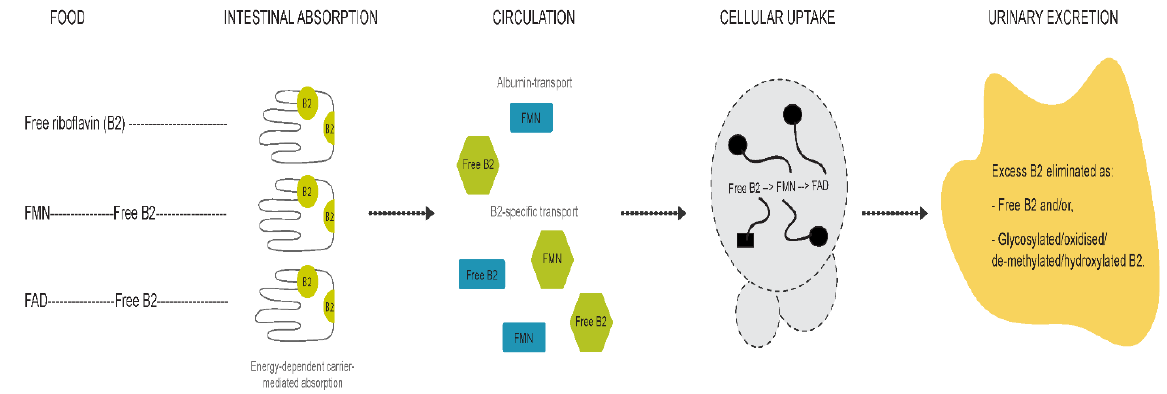
Figure 5. Graphical representation of vitamin B2 metabolism. Plasma concentrations of riboflavin, pantothenic acid, and 4-pyridoxic acid (4-PA) were positively associated with adult age (28–71 years). This is consistent with reports of age-specific changes in vitamin B6 status (i.e., decreases in pyridoxal 5’-phosphate (PLP) and/or plasma/urinary increases in its catabolite 4-PA) [20,34,35]. Age-dependent changes in B6 status have been proposed to be due to decreased intake, higher catabolic rates, increased enzymatic activity of alkaline phosphatase (responsible for PLP hydrolysis into pyridoxal (PL) and 4-PA), as well as variations in kidney function that impact B vitamer excretion [20,36,37]. The synthesis of PLP in tissues occurs via pyridoxine oxidation by FMN (riboflavin coenzyme) dependent enzymes (i.e., pyridoxine phosphate oxidase (PPO)) [37,38]. Since excess PLP is catabolized into PL then 4-PA, positive associations of 4-PA with age may reflect increased PLP turnover and catabolism with higher circulating riboflavin concentrations. Plasma pantothenic acid concentrations were also positively as- sociated with age. Notably, plasma concentrations of pantothenic acid are more readily affected by recent dietary intakes compared to its bound forms found within erythrocytes (i.e., coenzyme A) [39]. Studies in rural Japan have reported a decline in erythrocyte pan- tothenic acid with age, and proposed a potential decreased capacity of synthesising bound pantothenic acid in older adults [39–41]. While results from exclusively rural areas may not be relevant to populations in Australia, it is plausible to suggest that recent dietary intake affects plasma pantothenic acid, or that higher plasma pantothenic acid may reflect a lower capacity of synthesising its bound form in the tissues of older individuals. These age-dependent differences highlight the need to account for age when profiling B vitamers and the potential for using metabolomics to characterise physiological changes underly- ing the ageing process. We identified sex-specific differences in some B vitamers in our study. One of the challenges in nutritional metabolomics is that it is unclear whether changes in blood me- tabolites are caused by the diet itself, by upregulation of dietary co-factors/co-enzymes involved in food metabolism, or by a combination of both [42–46]. Given the ubiquitous availability of these vitamers in foods [3], different B vitamer concentrations by sex and age may solely represent differences in the amounts of foods consumed [47,48], and/or an upregulation by feedback response of the enzymatic machinery involved in metabolic re- actions associated with increased energy intake and production (e.g., the Krebs cycle, amino and fatty acid metabolism). Sexual dimorphism has been observed in several groups of nutritional metabolites (e.g., vitamin B12, vitamin C, vitamin D, vitamin B6, folates, lipids, amino acids, trimethylamine N-oxide (TMAO), betaine, choline, carnitine, dimethylglycine), and genetic variants have been associated with the status of some of these metabolites [46,49–55]. Differences in hormonal fluctuations, body composition,